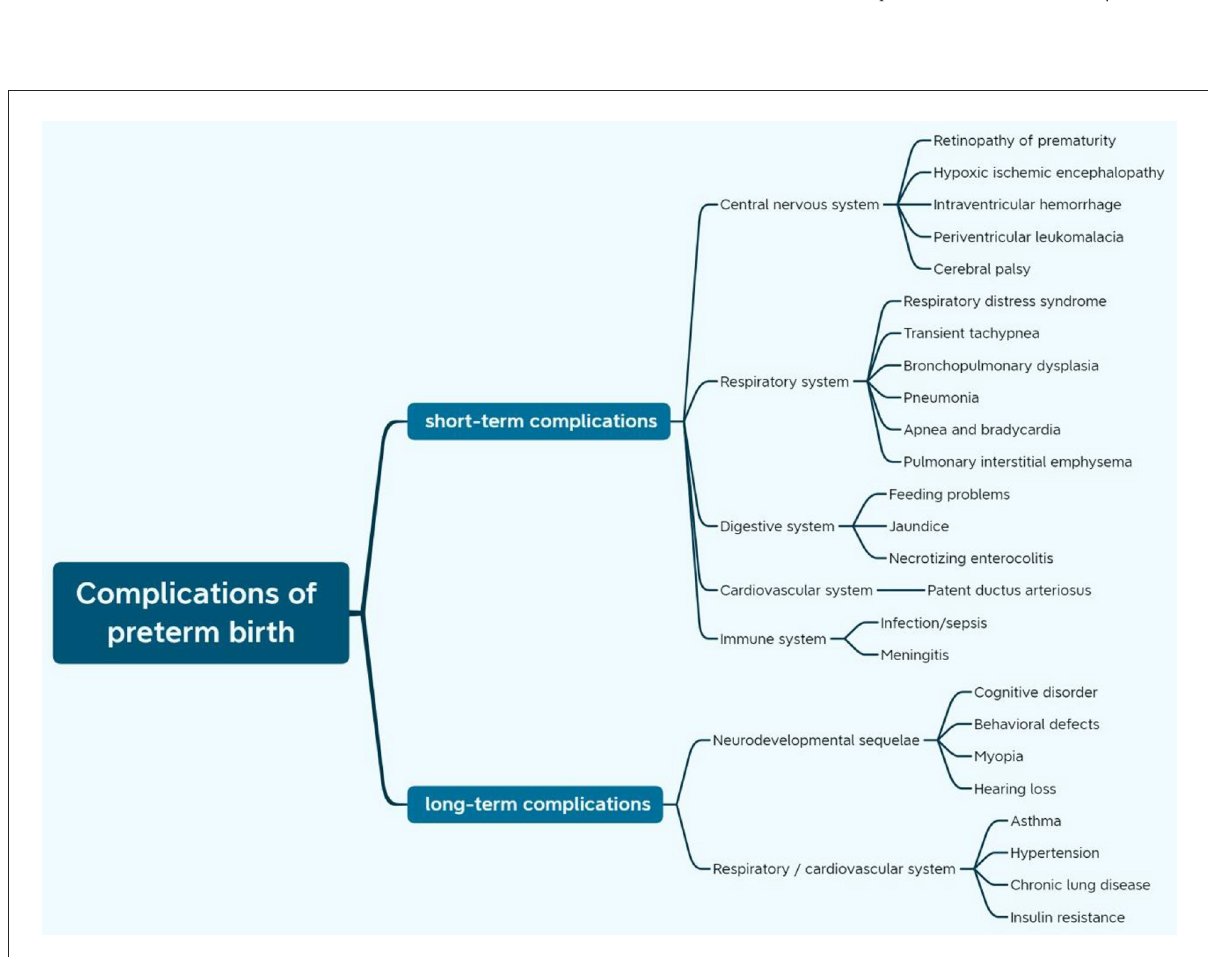
FIGURE1 Complications of preterm